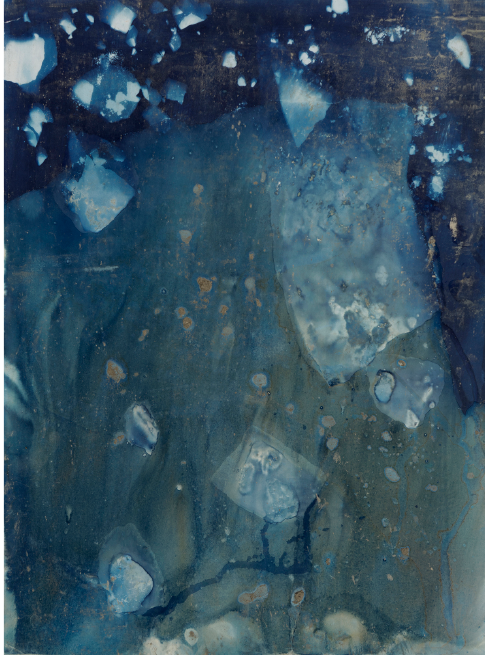
Figure 7: Downwaste (Swiftcurrent II), 2019. Cyanotype on paper 30" x 22". Courtesy of Jonathan Marquis. Downwaste gallery available at: